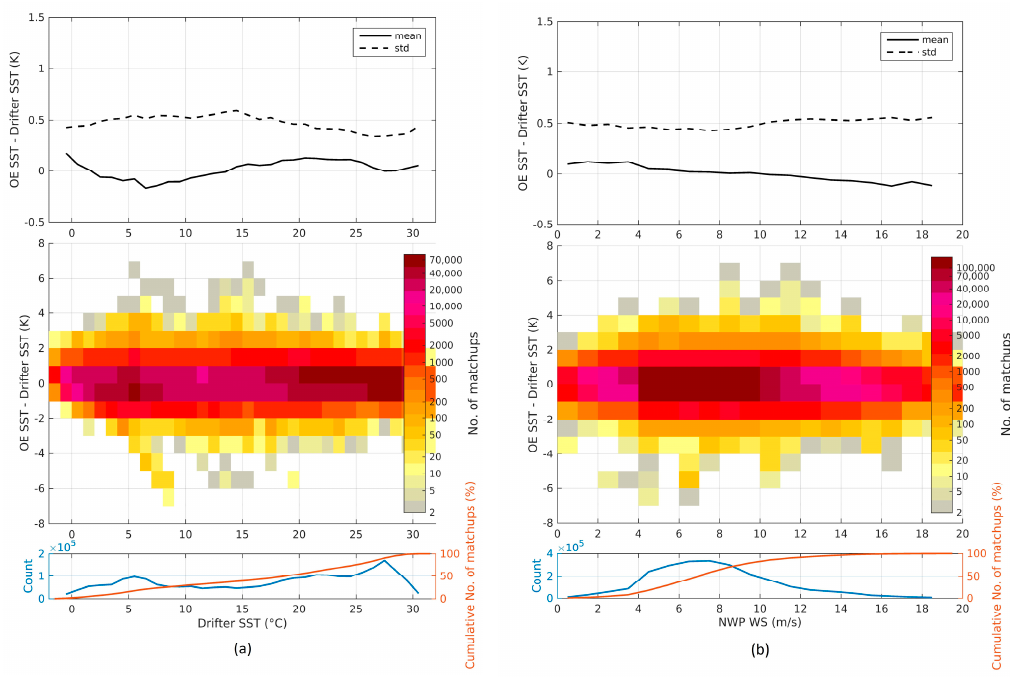
Figure 9. OE SST minus drifter SST as a function of binned ( a ) Drifter SST; ( b ) NWP WS. Solid lines are bias and dashed lines are standard deviation in the upper figures. The surface plots in middle figures show the number of matchups in each bin, while the bottom plots show the total number of matchups (blue) and the cumulative percentage of matchups (red) in each drifter SST and NWP WS bin, respectively. Only retrievals with a corresponding RMSE TB < 0.5 K are plotted in the figures.